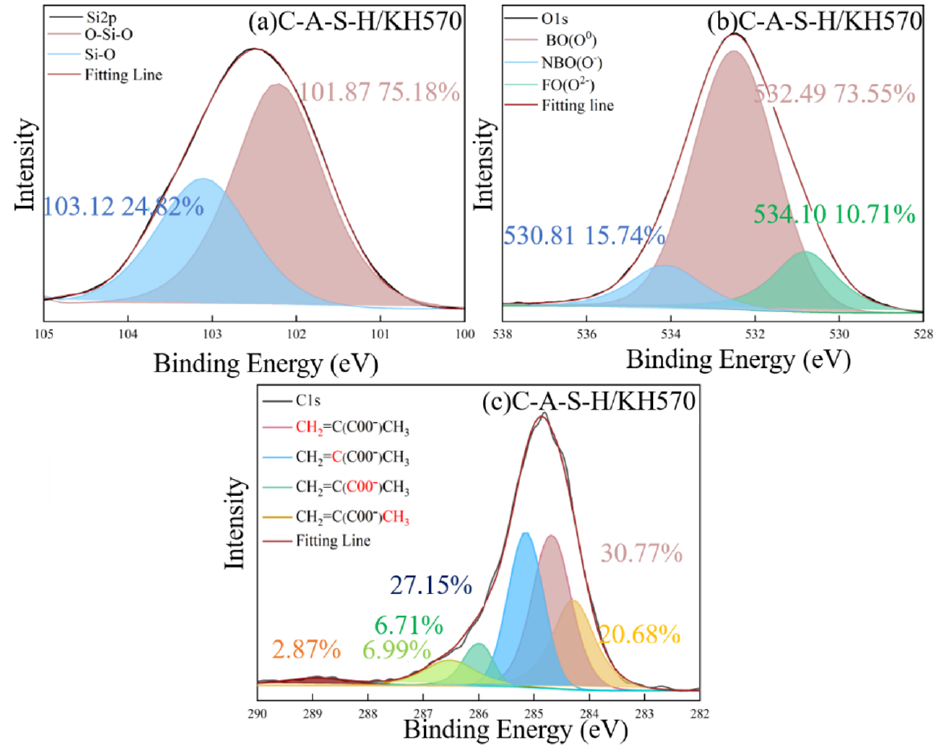
Figure 15. The XPS deconvolution spectrum of ( a ) Si 2p, ( b ) O1s, ( c ) Ca 2p/3 of C ‐ A ‐ S ‐ H/KH570.